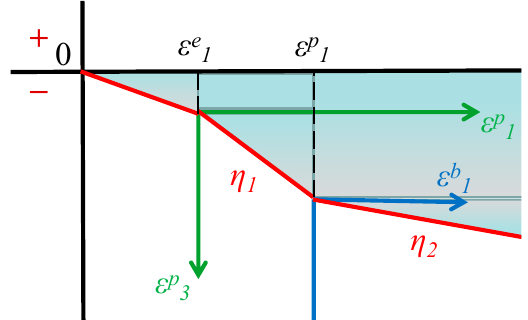
Figure 4. Dilatation effect model of tunnel surrounding rock.